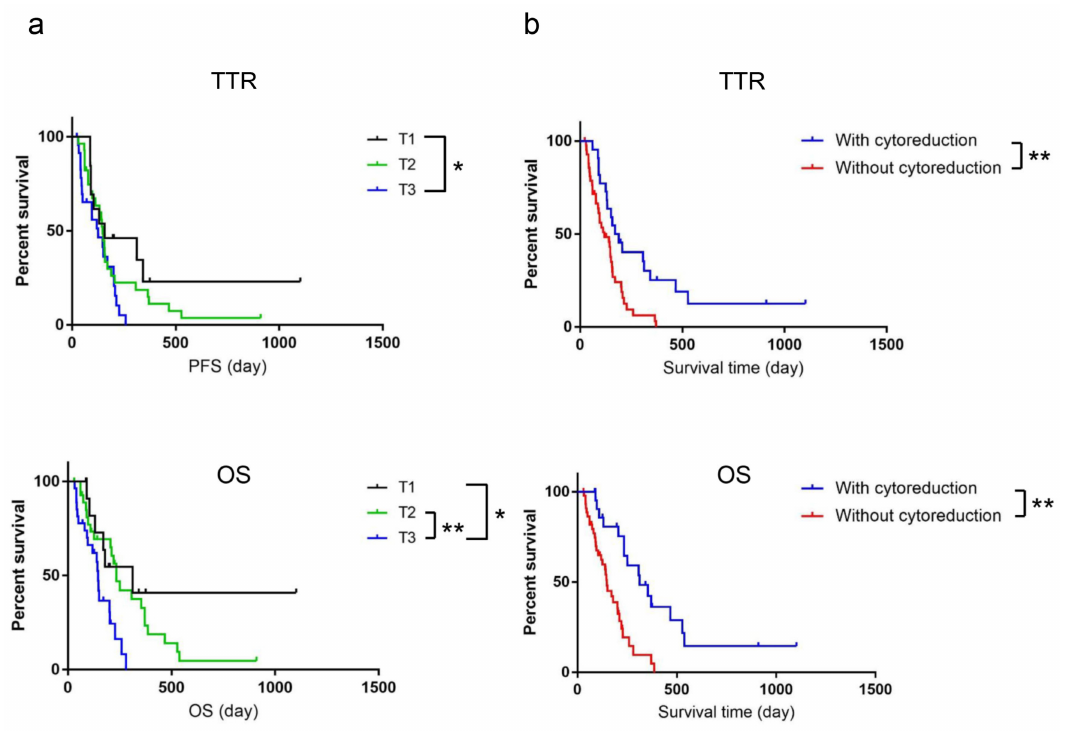
Figure 2. Kaplan–Meier survival curves of dogs with oral melanoma evaluated on the basis of tumor size, (( a ) T1 ( n = 13), T2 ( n = 28), and T3 ( n = 27)); and cytoreduction, ( b ) with cytoreduction ( n = 23) and without cytoreduction ( n = 45). Significant differences were observed between the groups in brackets. * p < 0.05, ** p <